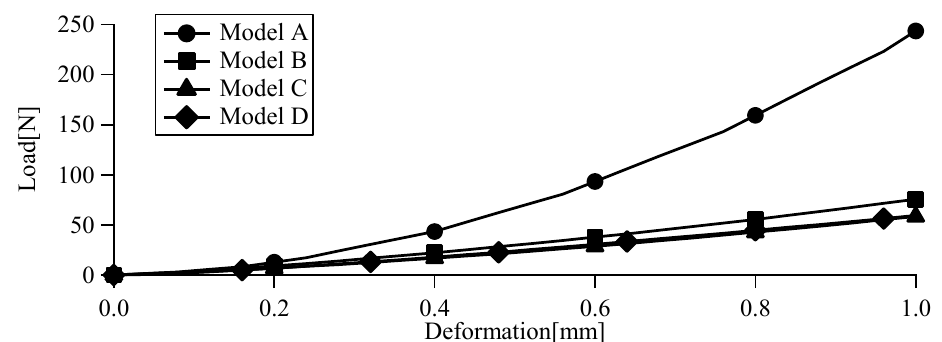
Figure 7. Relationships between deformation and load (Strain rate = 10%/s)